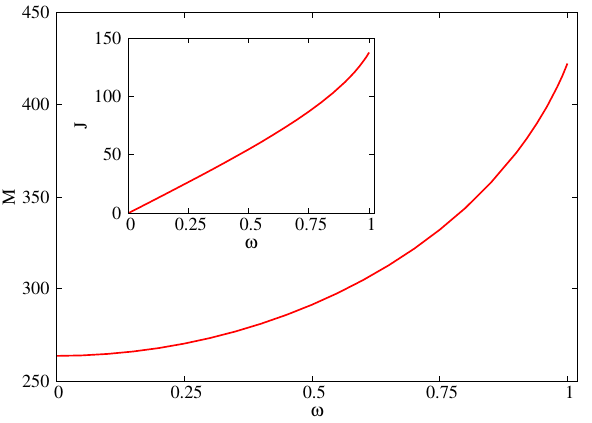
Figure 1 . Left panel: the pro(cid:12)les of d = 5 static and spinning Skyrmions, on a (cid:13)at spacetime background are shown together with their energy density. Right panel: the distribution of the angular momentum density for spinning Skyrmions. The inset shows the values of the parameter f 1 which enters the small (cid:0) r expression of the solutions.